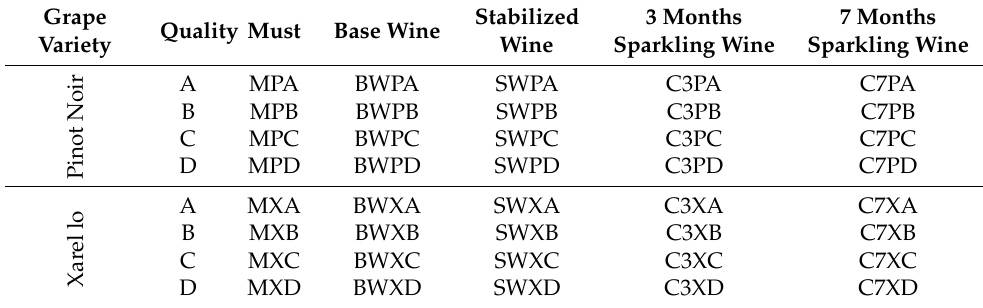
Table 1. List of samples under study. Sample codes are as follows: M, must; BW, base wine; SW, stabilized wine; C3, 3 months in rhyme cava wine (sparkling wine); C7, 7 months in rhyme cava wine (sparkling wine); P, Pinot Noir; X, Xarel lo; A, quality A; B, quality B; C, quality C; D, quality D. Stabilized 3 Months 7 Grape Quality Must Base Wine Wine Sparkling Wine Variety